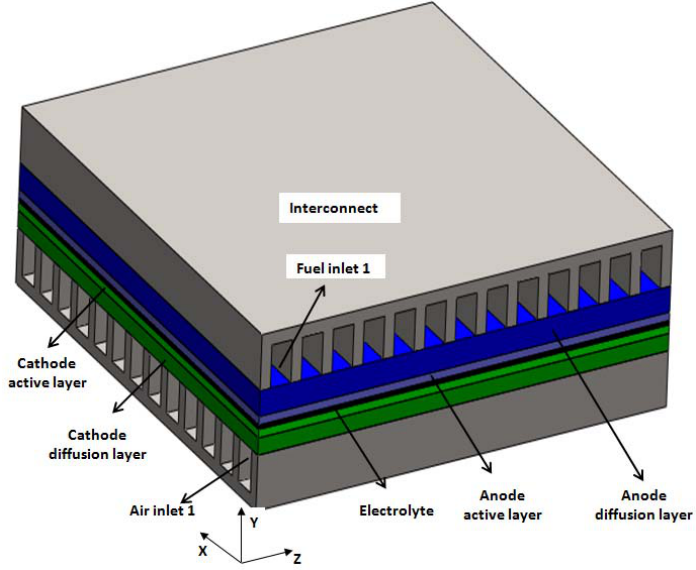
Figure 1. Sketch of anode-supported planer SOFC structure for cross-flow configuration (not in scale).